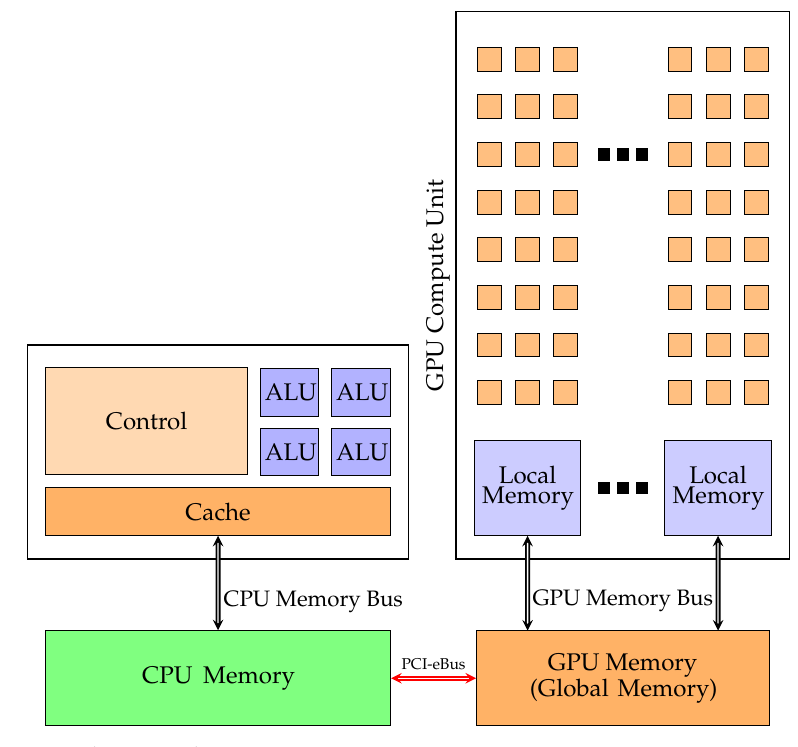
Figure 6. CPU and GPU